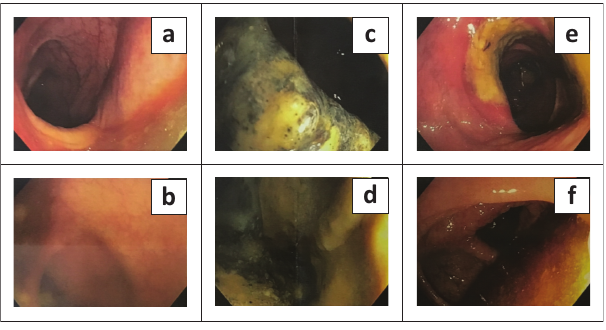
Source : Colonscopy pictures of actual patient captured by V.V. Ramkelawon FIGURE 2: Colonoscopy findings: Areas of normal mucosa (a and b), necrotic mucosa (c and d) and inflamed mucosa (e and f).